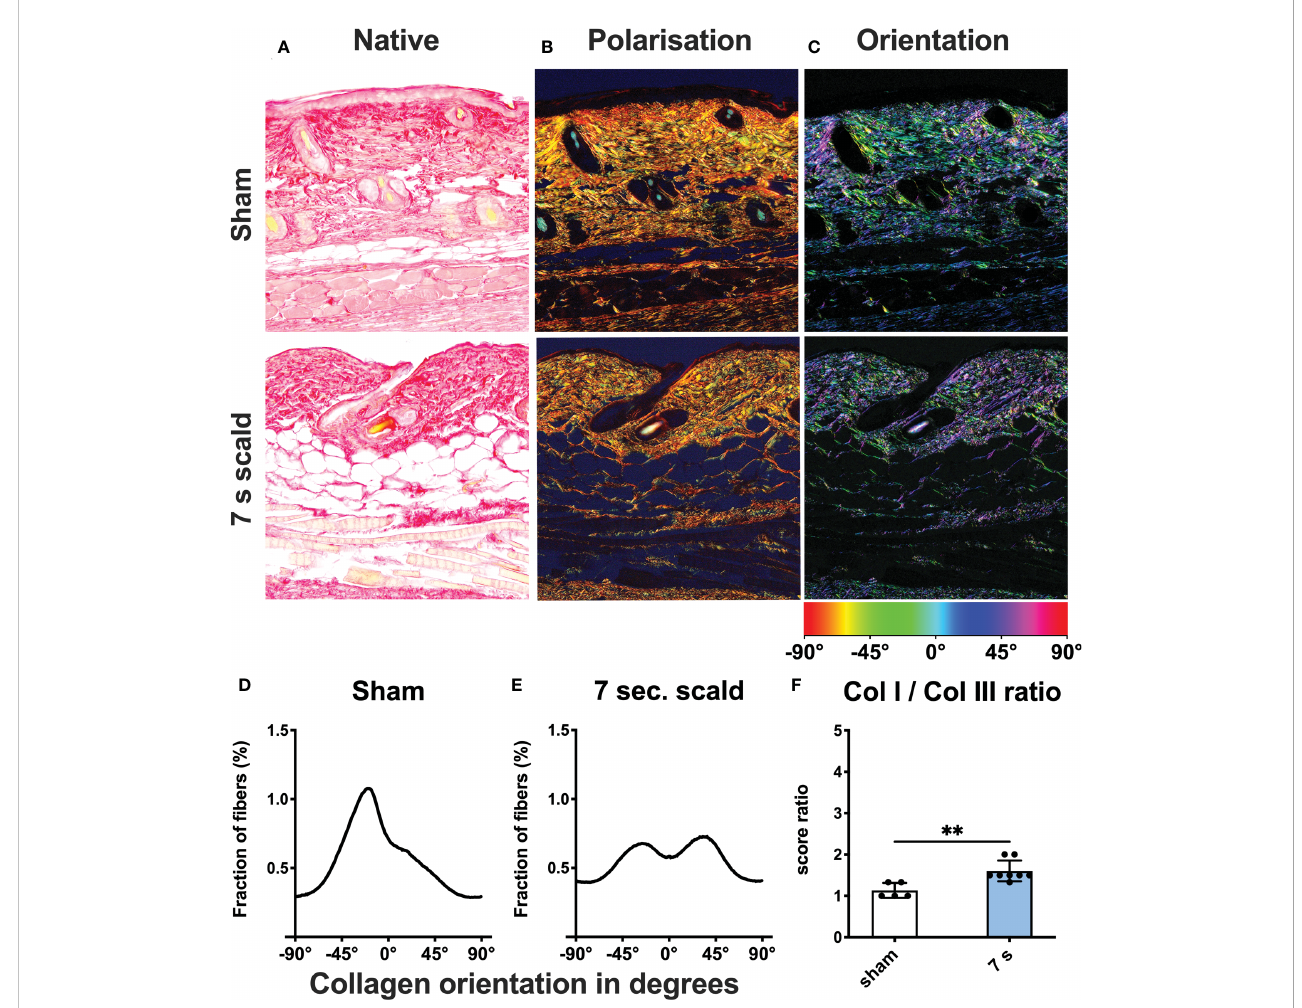
FIGURE 6 Dermal collagen composition and orientation after 24 h. Representative images of native (A) and polarized (B) picro sirius red stains of sham and 7 s scald are shown. Green represents collagen III and red represents collagen I fi bers. The ratio of the semiquantitative scores (F) is illustrated to visualize the changes in collagen composition after thermal injury. Results are provided as mean ± SD. For comparison, an unpaired t -test was performed. The level of signi fi cance is: **p < 0.01. Distribution of fi bers is visualized using a color-based scale (C) . The fraction of fi bers is displayed as a function of orientation in degree for sham (D) and 7 s scald (E) . The graph represents the mean of all individuals of each